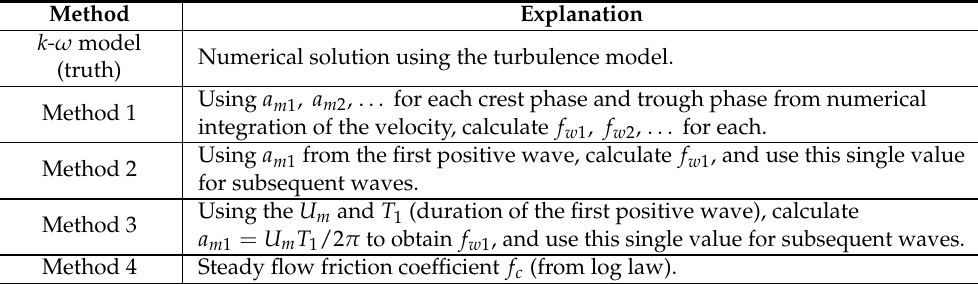
Table 2. Calculation method of bottom shear